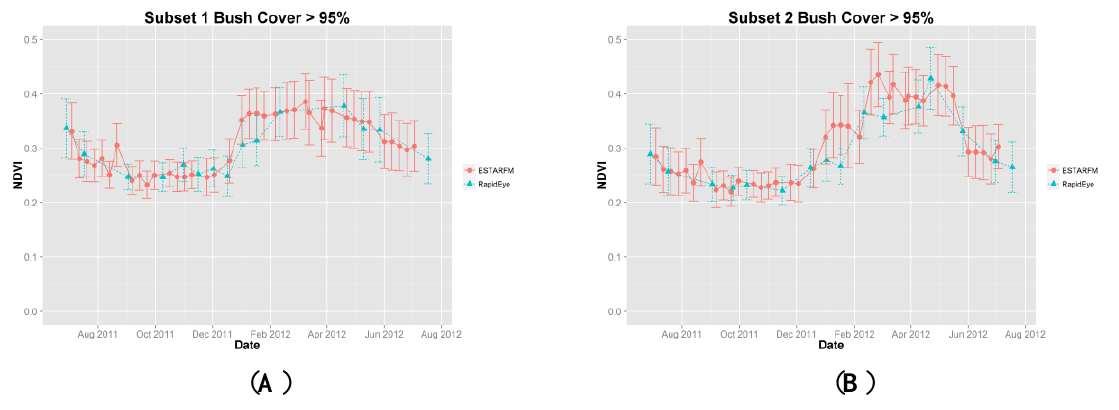
Figure 7. Time series of mean NDVI values calculated for all MODIS pixel size extents classified as containing >95%. See Figure 6 for detailed description of sub-plots. ( A ) subset 1; ( B ) subset